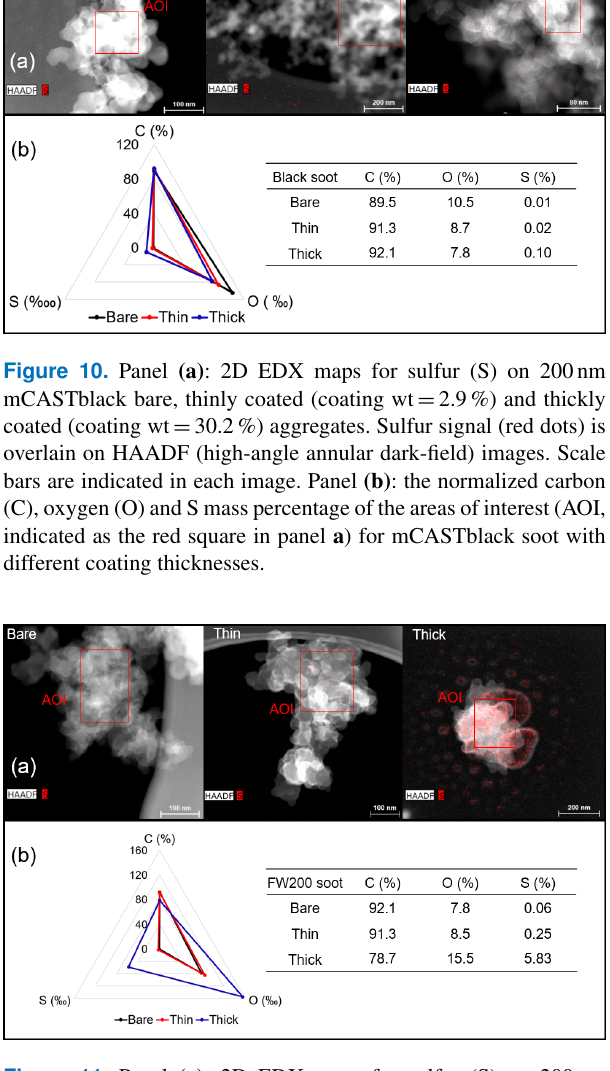
Figure 11. Panel (a) : 2D EDX maps for sulfur (S) on 200nm FW200 bare, thinly coated (coating wt = 2.3%) and thickly coated (coating wt = 139.3%) aggregates. Sulfur signal (red dots) is over- lain on HAADF images. Scale bars are indicated in each image. Panel (b) : the normalized carbon (C), oxygen (O) and S mass per- centage of the AOI (indicated as the red square in panel a ) for FW200 soot with different coating thicknesses.